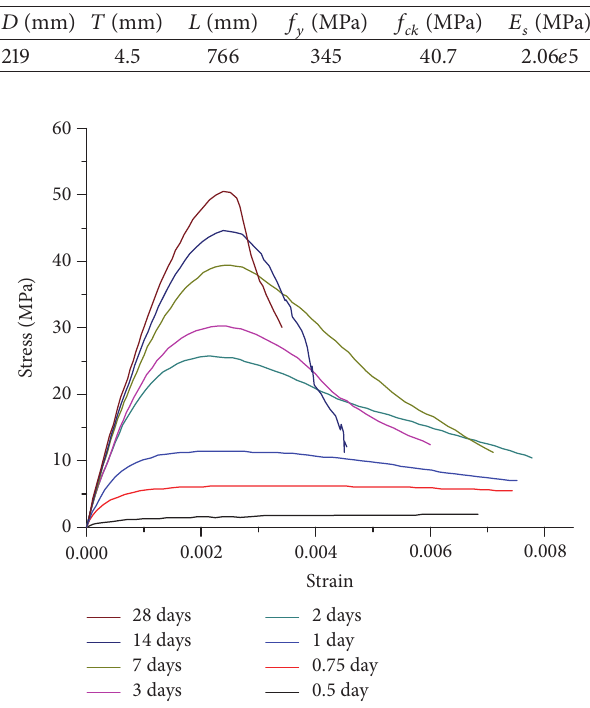
Table 1: Geometrical and mechanical properties of the specimens.